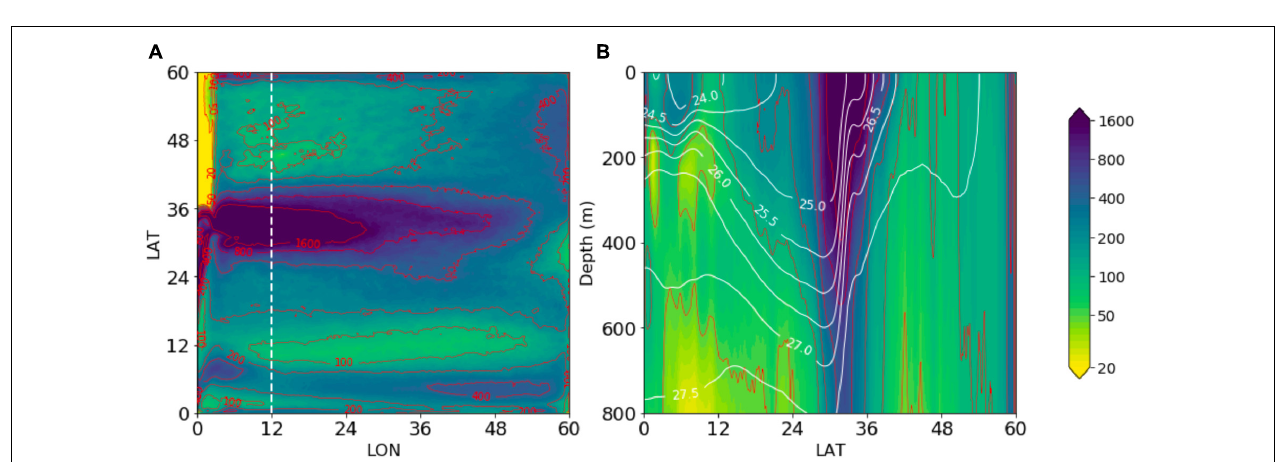
FIGURE 5 | Time-averaged SSH (in meters) from the four experiments. The contour interval is 0.1 m. The dashed line marks the latitude of the maximum wind stress curl. (A–D) Correspond to experiments D1, D3.2, D10, and D32, respectively.